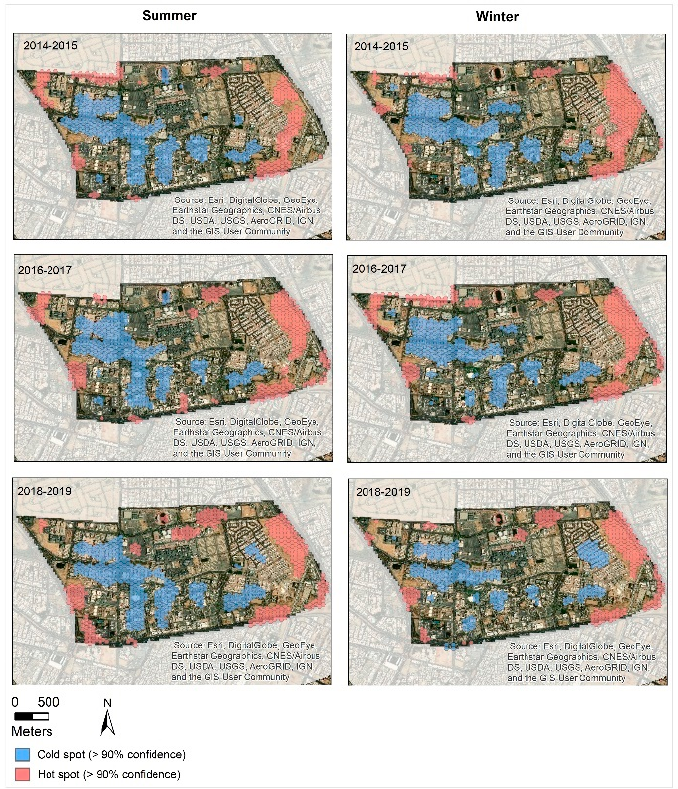
Figure 7. Hot spots and cold spots of LST in the summer and winter of 2014–2015, 2016–2017, and 2018–2019.